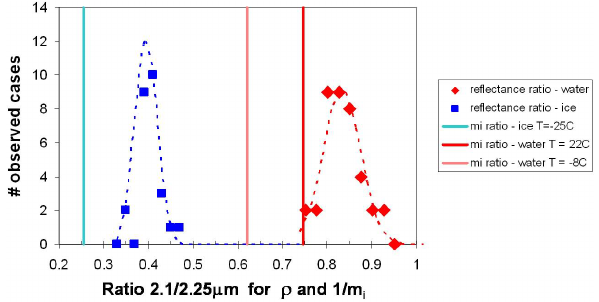
Fig. 10. Histograms of experimental measurements of the re- flectance ratio ρ 2 . 10 / ρ 2 . 25 µ m for ice and water clouds. The red dots show results for the water portion of convective clouds and the blue dots for the ice component. The vertical lines show ratios of the (1/ m i ) factor for the same wavelength ratio, where m i is the imag- inary component of the refractive indices of water (red colors for 2 different temperatures) and ice